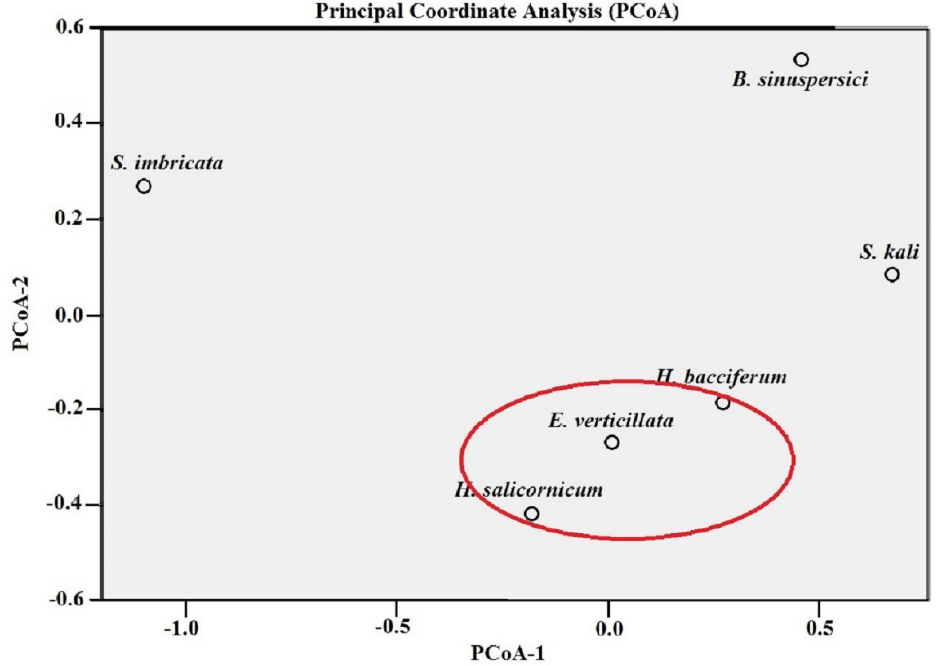
Figure 6. Multidimensional scaling using principal coordinate analysis (PCoA) plots of the CF% of EF of the six plant hosts showing ordination of plant species data sets of CF%. PCoA was done based on a distance-dissimilarity matrix using Euclidean distance of CF% to have a plot in the common two-dimensional space. Red circles show the close coordination of CF% of three correlated plant hosts.